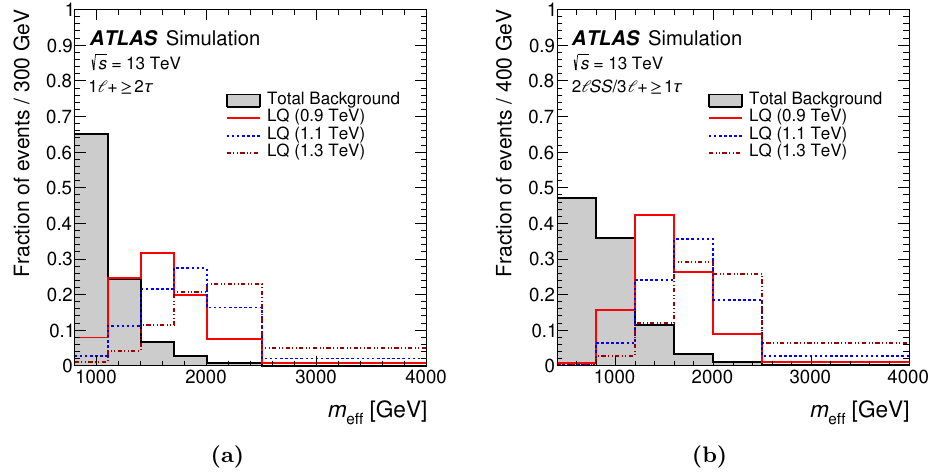
Figure 3. Comparison of the m eff distribution in (a) the 1 ‘ + ≥ 2 τ SR, and (b) the 2 ‘ SS/ 3 ‘ + ≥ 1 τ SR-H, between the total background (shaded histogram) and the LQ signal for different mass values. The last bin in each distribution contains the overflow.